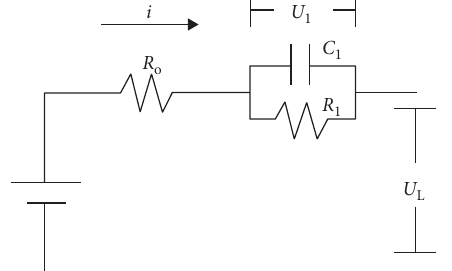
Figure 3: Equivalent circuit model of a lithium-ion